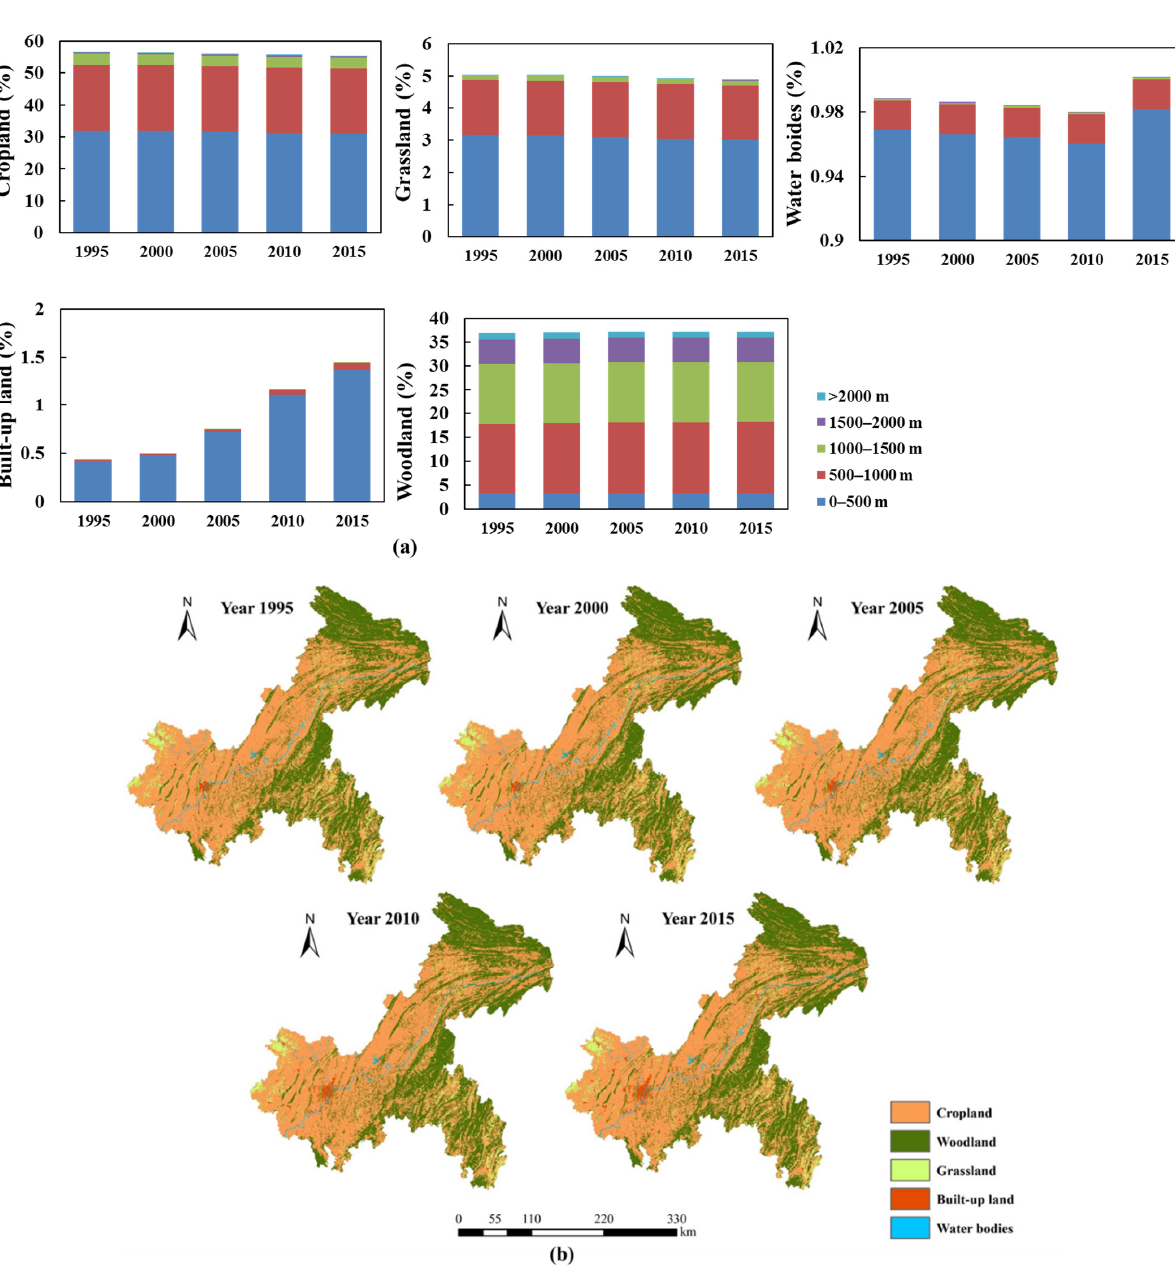
Figure 2. Proportions of land use types at different altitude gradients from 1995 to 2015 ( a ). Spatial distributions of land use in Chongqing from 1995 to 2015 ( b ).